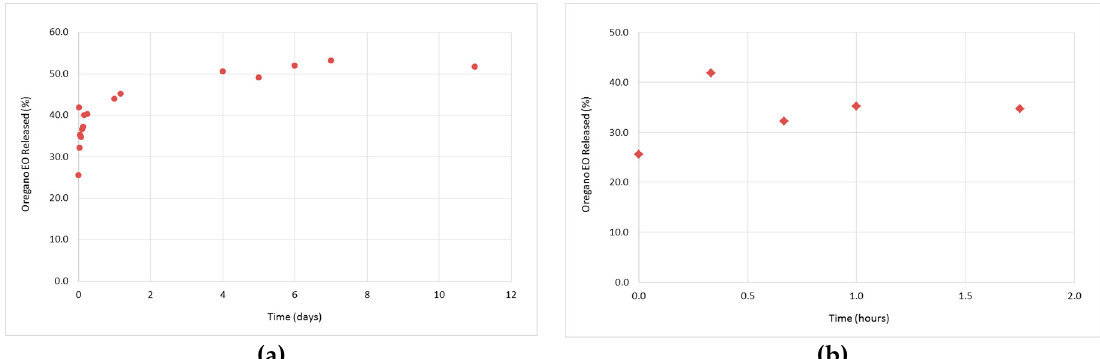
Figure 7. Release profile of the encapsulated oregano EO at 50 °C and pH 7.4, during 11 days ( a ), as well as at the first 1 h and 45 min of the experiment ( b ).